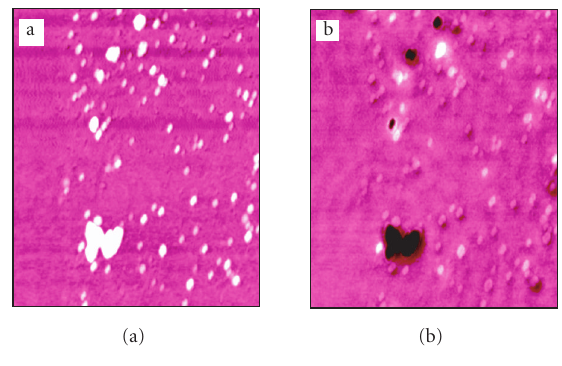
Figure 37: Shear-force AFM (a) (500nm, Z range 100nm) and apertureless SNOM (b) of an expired blood bag surface at a particu- larly flat site showing widespread and pronounced localized optical contrast.